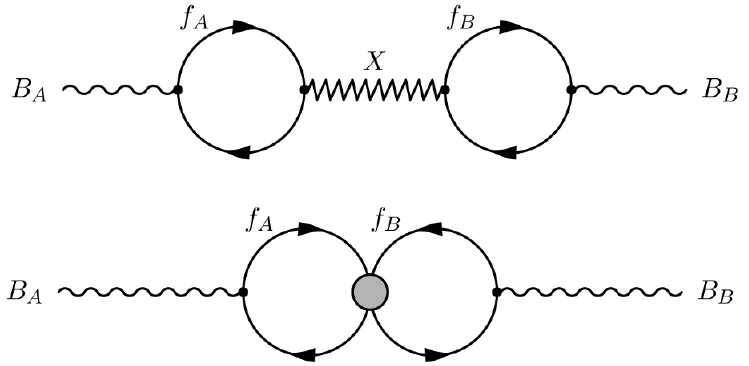
Figure 3 . Loop level mixing of SM and twin hypercharge boson through X . Bottom graph with X integrated